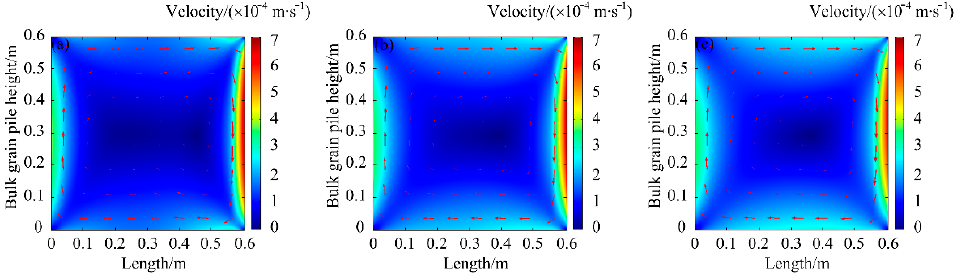
Figure 10. Velocity distribution in the middle plane of the bulk grain pile at different times: ( a ) 24 h; ( b ) 48 h; ( c ) 72 h.